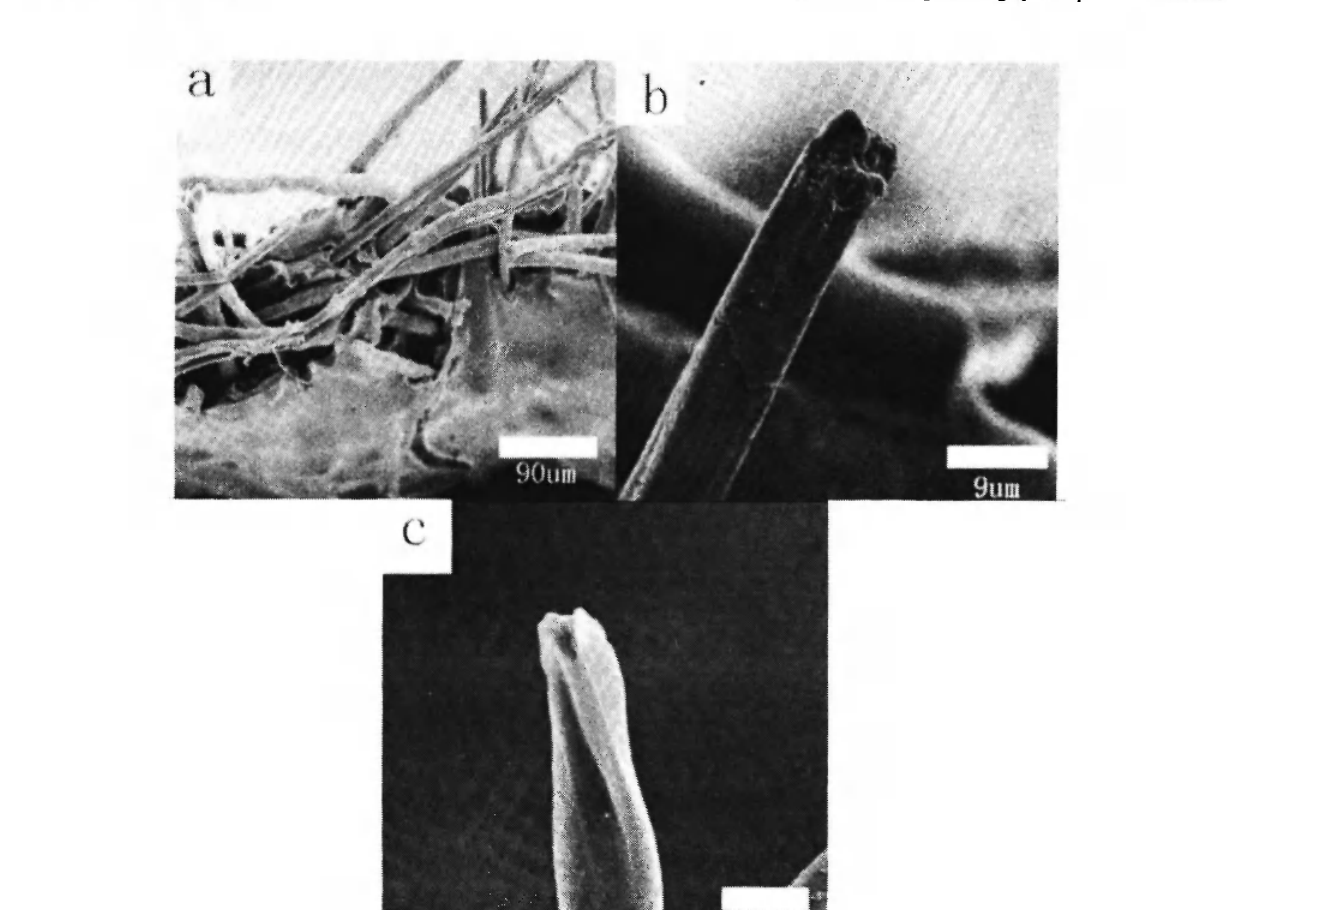
Fig. 3: (a) SEM image of the fracture surface of the sample 3 after tensile test, (b) SEM image of one fiber at the fracture surface, (c) SEM image of a chitosan fiber that directly